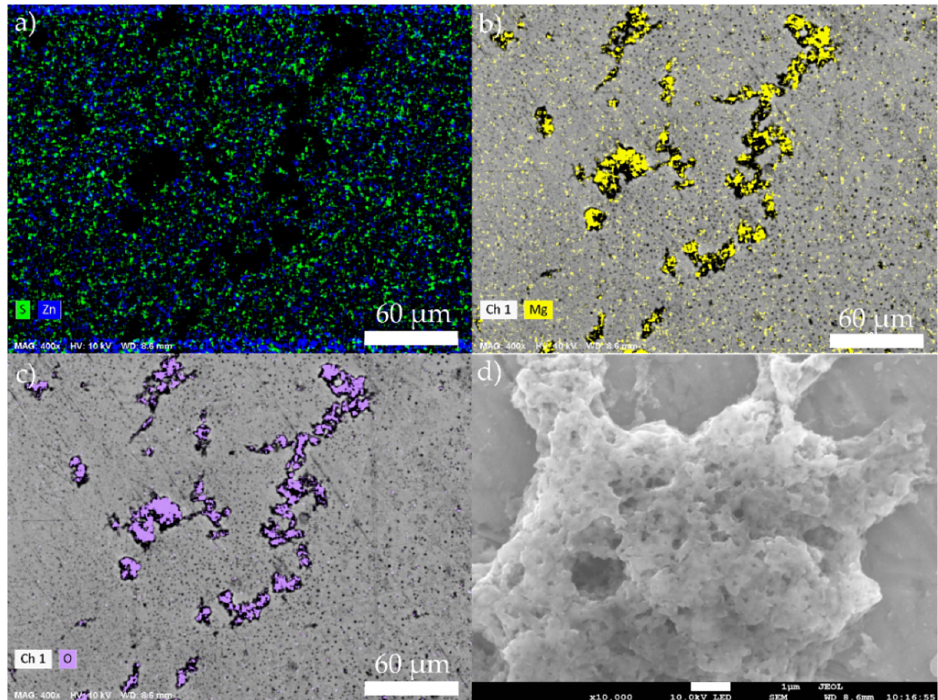
Figure 6. Mapping of location elements for the surface of Cu-activated sphalerite conditioned with SIPX in presence of Mg and morphology of the precipitated Mg(OH) 2 : ( a ) S and Zn, ( b ) Mg, ( c ) O, ( d ) morphology.